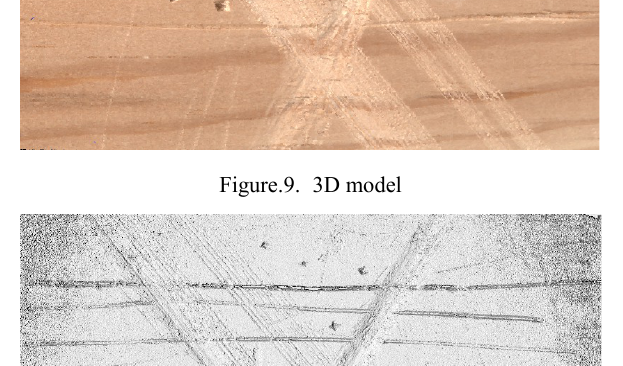
Figure.8.  3D model Figure.9.Depth map with shading